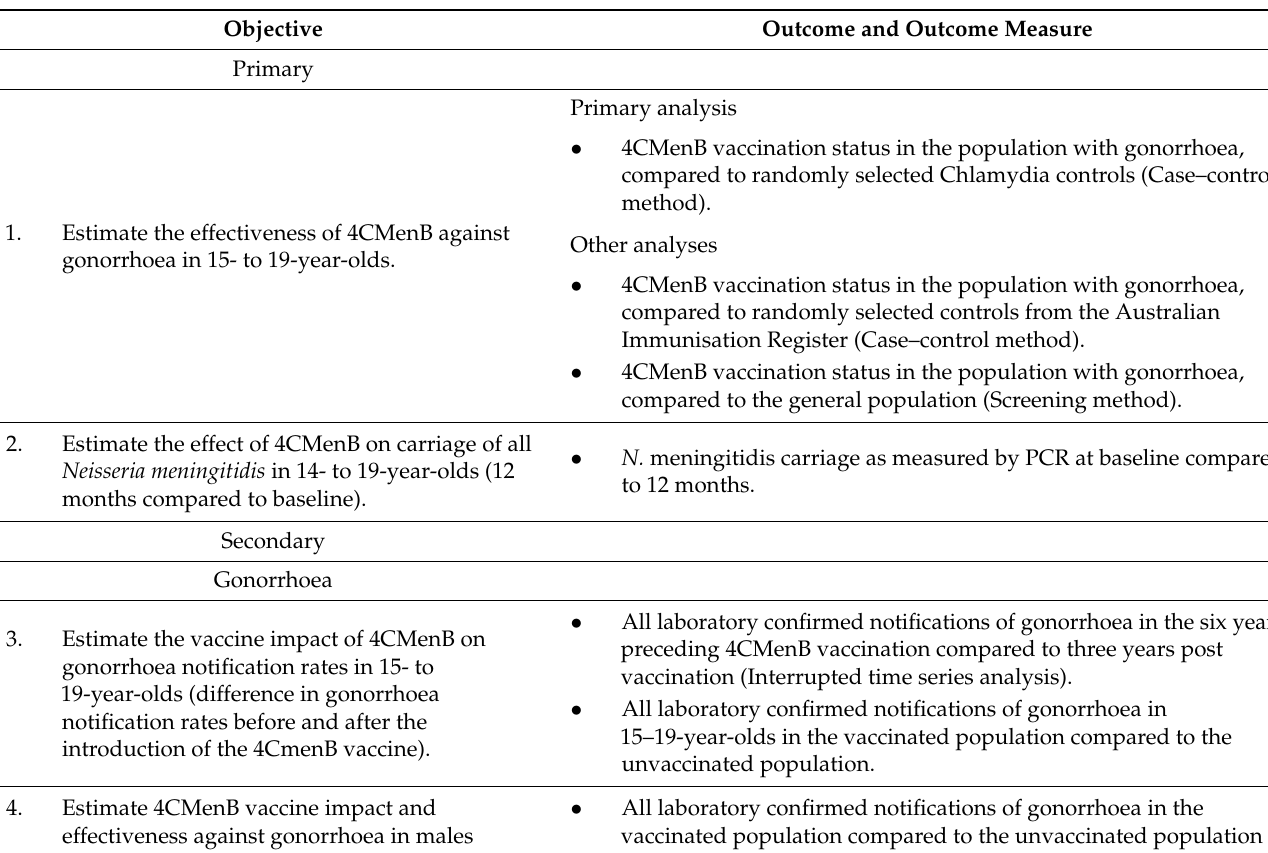
Table 1. Objectives and outcome